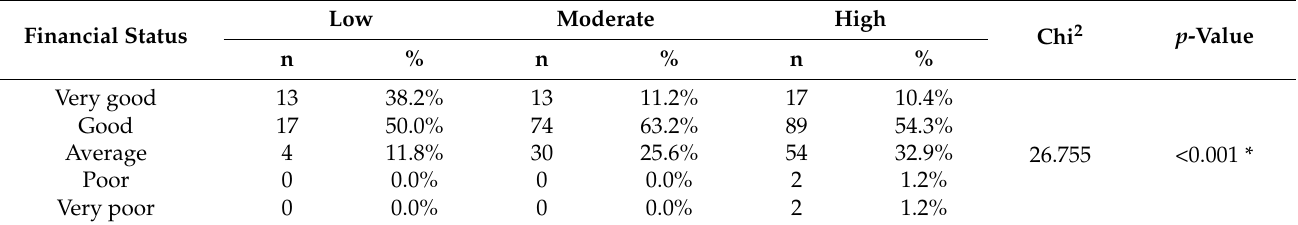
Table 6. The influence of financial status on the level state anxiety (n =